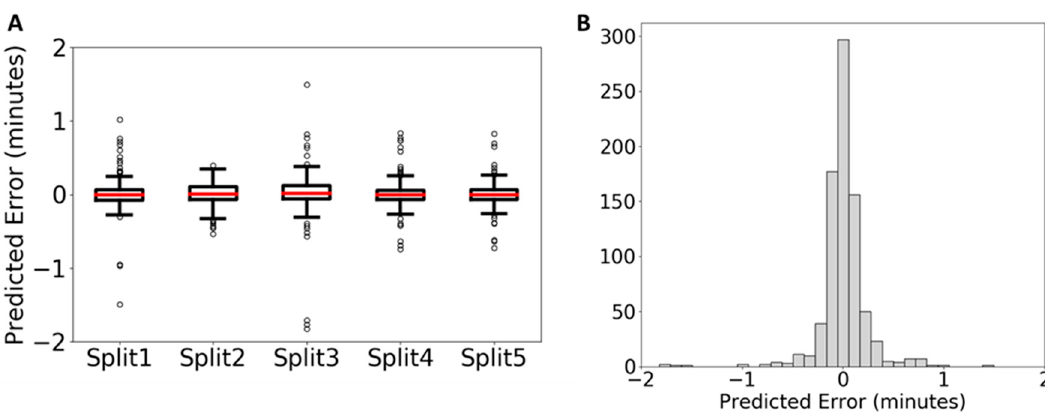
Figure 3. Analysis of lipidomics error. error of each prediction in absolute time is presented. This is presented with error divided by each test/training split ( A ) and the error of all compounds across all groupings ( B ) With all compounds ( B ) the y -axis represents the number of compounds at each error value.